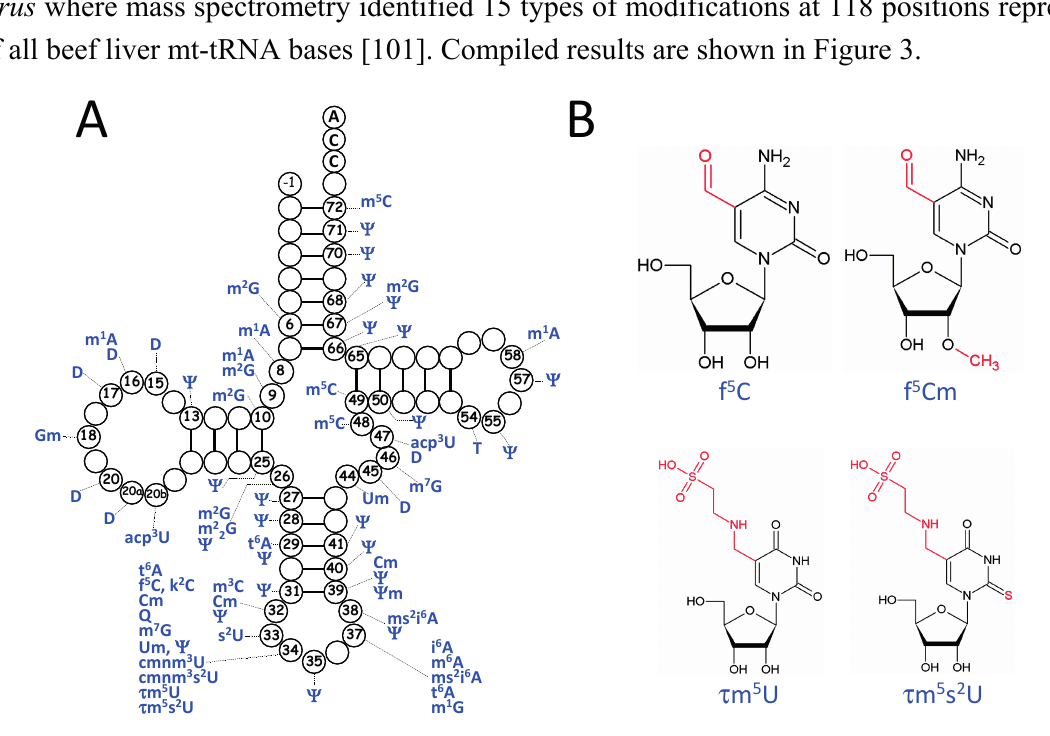
Figure 3. Distribution of post-transcriptional modifications in mt-tRNAs. ( A ) Localization of modifications in a tRNA cloverleaf (more details in Supplementary Table S1); ( B ) Structure of mitochondria-specific f 5 C and τ m 5 U and their derivatives. Modifications are given in standard abbreviations [91]. The cloverleaf shows position − 1, since some mt-tRNAs with His identity have a nucleotide at that